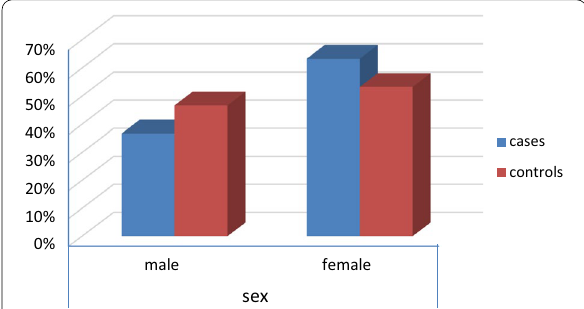
Fig. 1 Number and percent of males and females in patients and